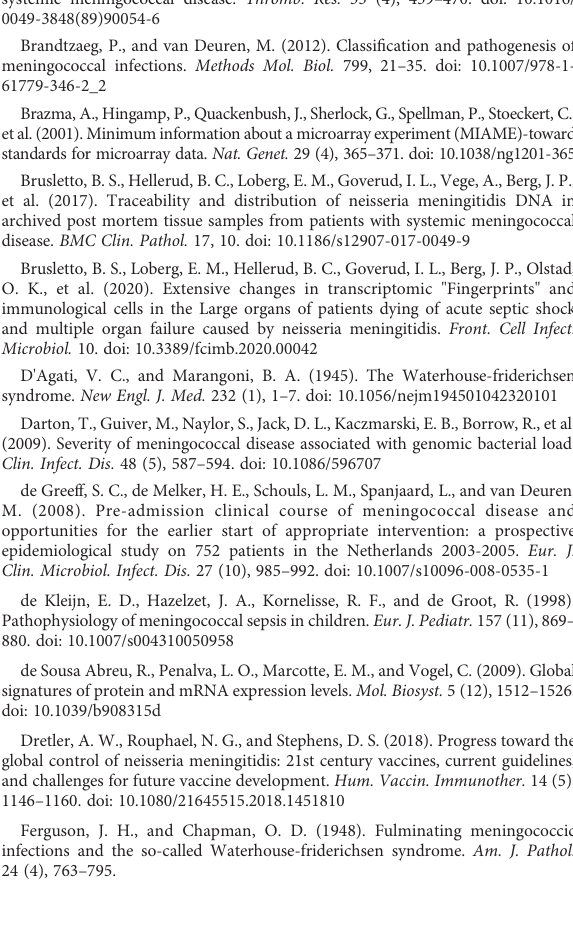
SUPPLEMENTARY FIGURE 1_1 Transcriptionalpro fi lesofcanonicalpathwaysinFFPE tissuesamplesfrom meningococcal septic shock patients. The fi gure displays the top canonical pathways enriched in each organ. A ≪ core analysis ≫ with FC ≥ |2.0| and p -value < 0.05 was performed separately for each organ. Signi fi cantly enriched canonical pathways were identi fi ed with a right- tailed Fisher ’ s exact test p < 0.05, after correction for multiple testing using the Benjamini-Hochberg method. The Z-score = | ± 2| indicates predicted activation state of canonical pathway. Blue color or lighter shades of blue indicate a negative Z-score and down-regulation of the